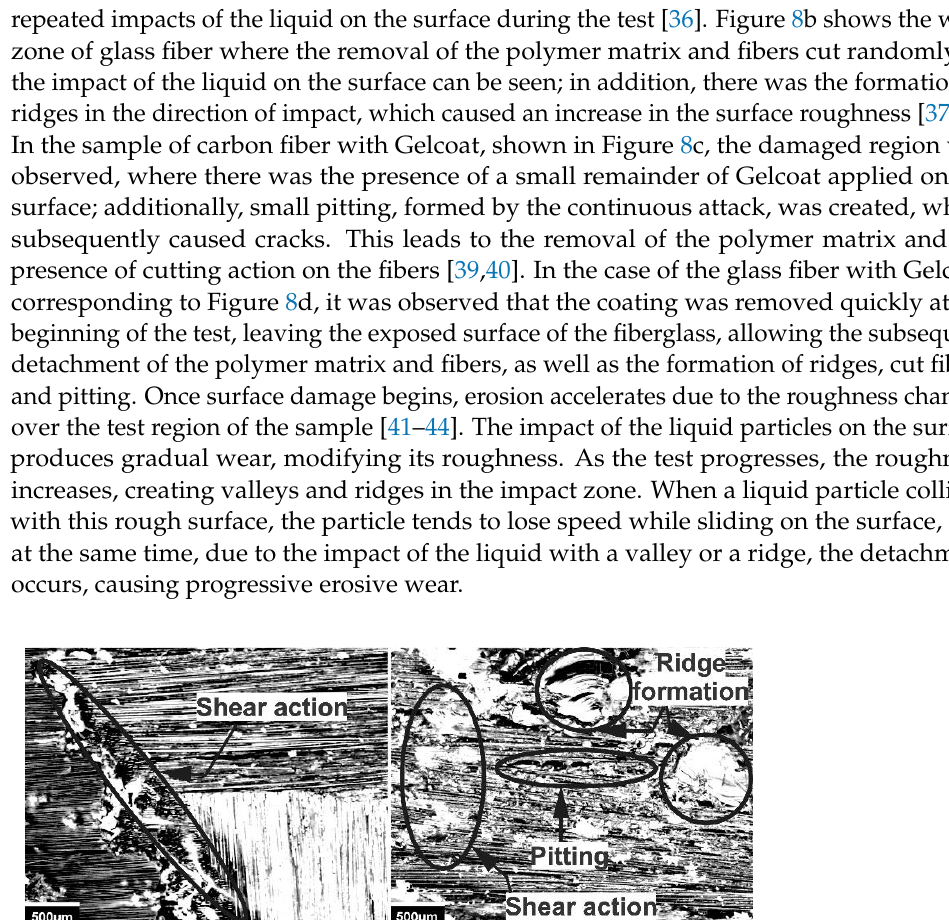
Figure 9. Cutting and detachment action: ( a ) carbon fiber and ( b ) glass fiber.